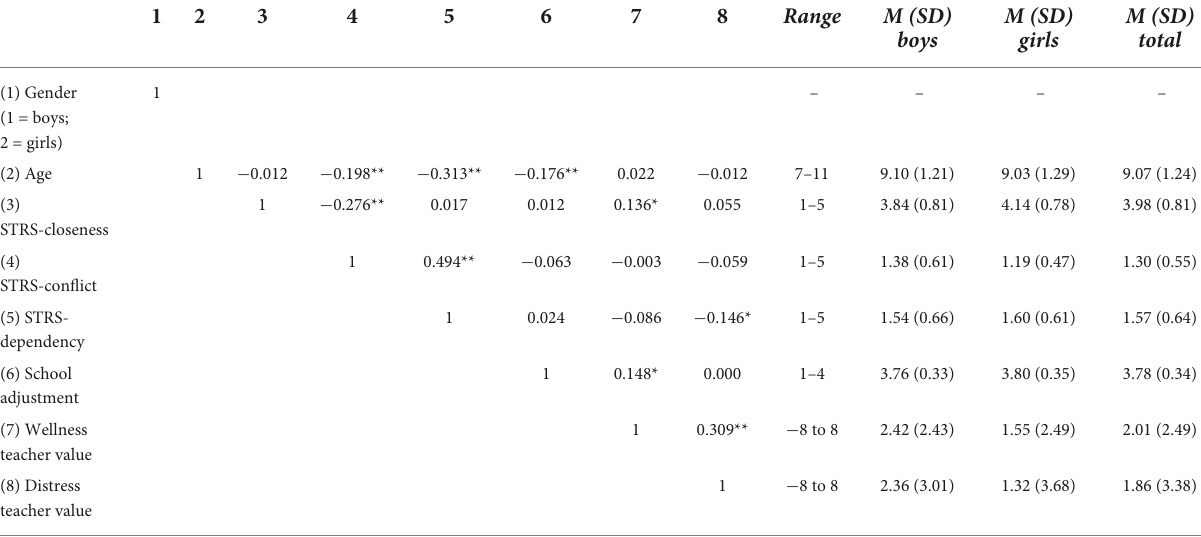
TABLE 1 Descriptive statistics and bivariate Pearson’s correlations on study